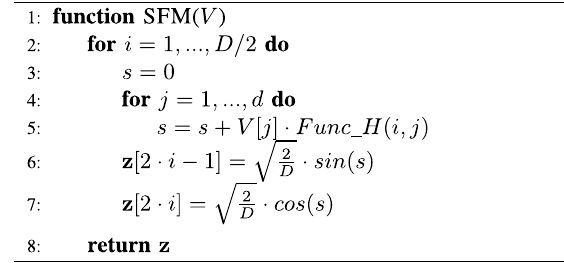
Algorithm 1 generates random numbers from a Cauchy